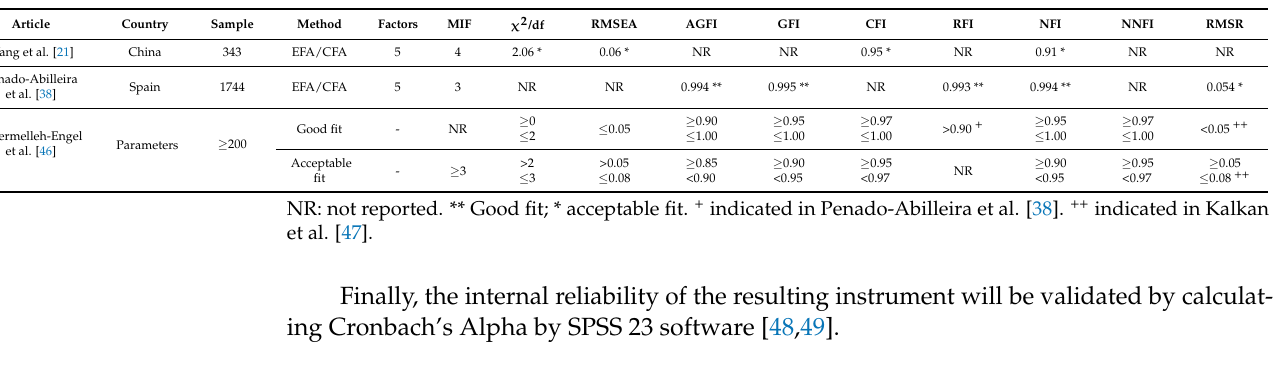
Table 1. Validation and reliability reported in previous articles and parameters.